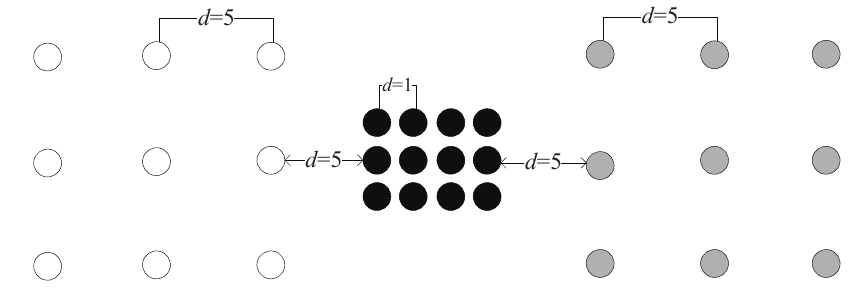
Figure 2. Illustration of the problem in DBSCAN